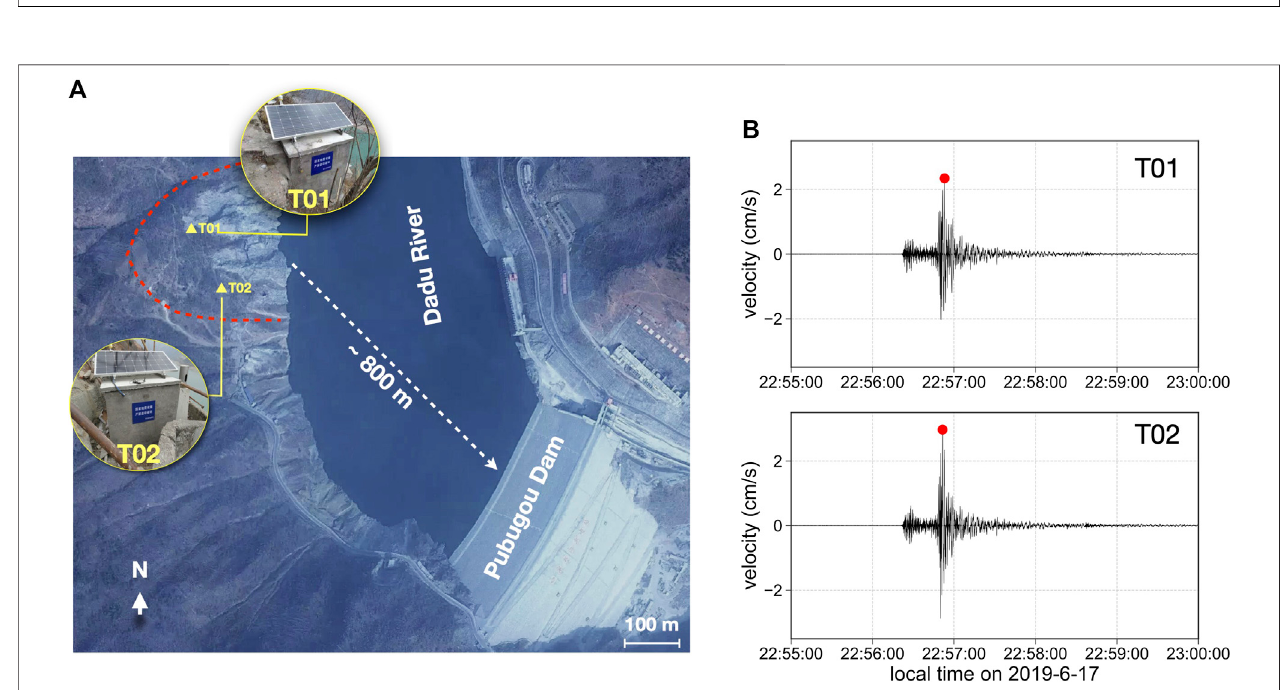
FIGURE 1 | (A) Tectonic settings surrounding the Pubugou slope (the hypocenter of the Changning Mw 5.7 earthquake is indicated by the black star). (B) Geological pro fi le of the slope, mainly composed of sedimentary rocks.